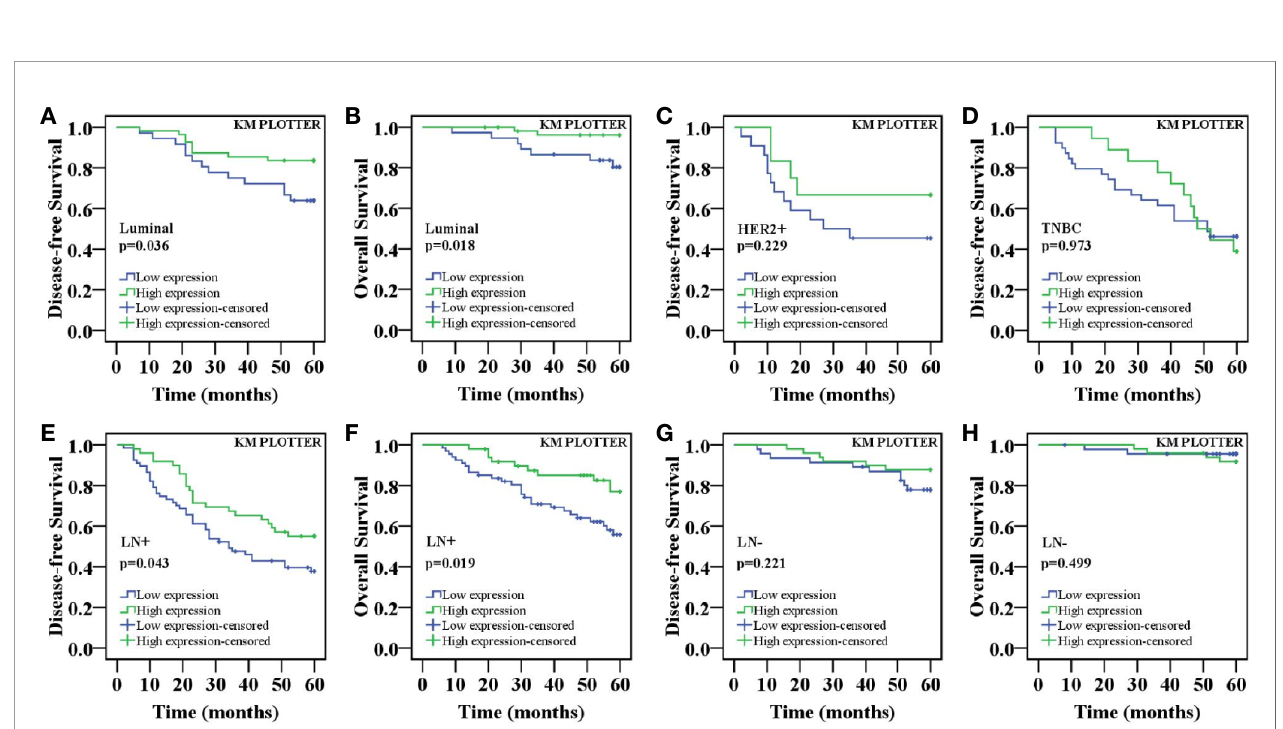
FIGURE 6 | K-M survival curves for the correlation of the nuclear ING3 expression in breast cancer patients. (A) Patients with low expression of nuclear ING3 staining had a signi fi cantly worse 5-DFS than those with high expression of ING3 staining in luminal-type patients. (B) A similar conclusion for 5-OS in luminal-type patients. (C, D) K-M survival analysis of the nuclear ING3 expression was not statistically signi fi cant for 5-DFS in HER2 positive-type and TNBC patients. (E – H) K-M survival curves for the correlation between the nuclear ING3 expression and 5-DFS and 5-OS in breast cancer patients with or without lymph node metastasis. LN-, lymph node metastasis negative; LN+, lymph node metastasis